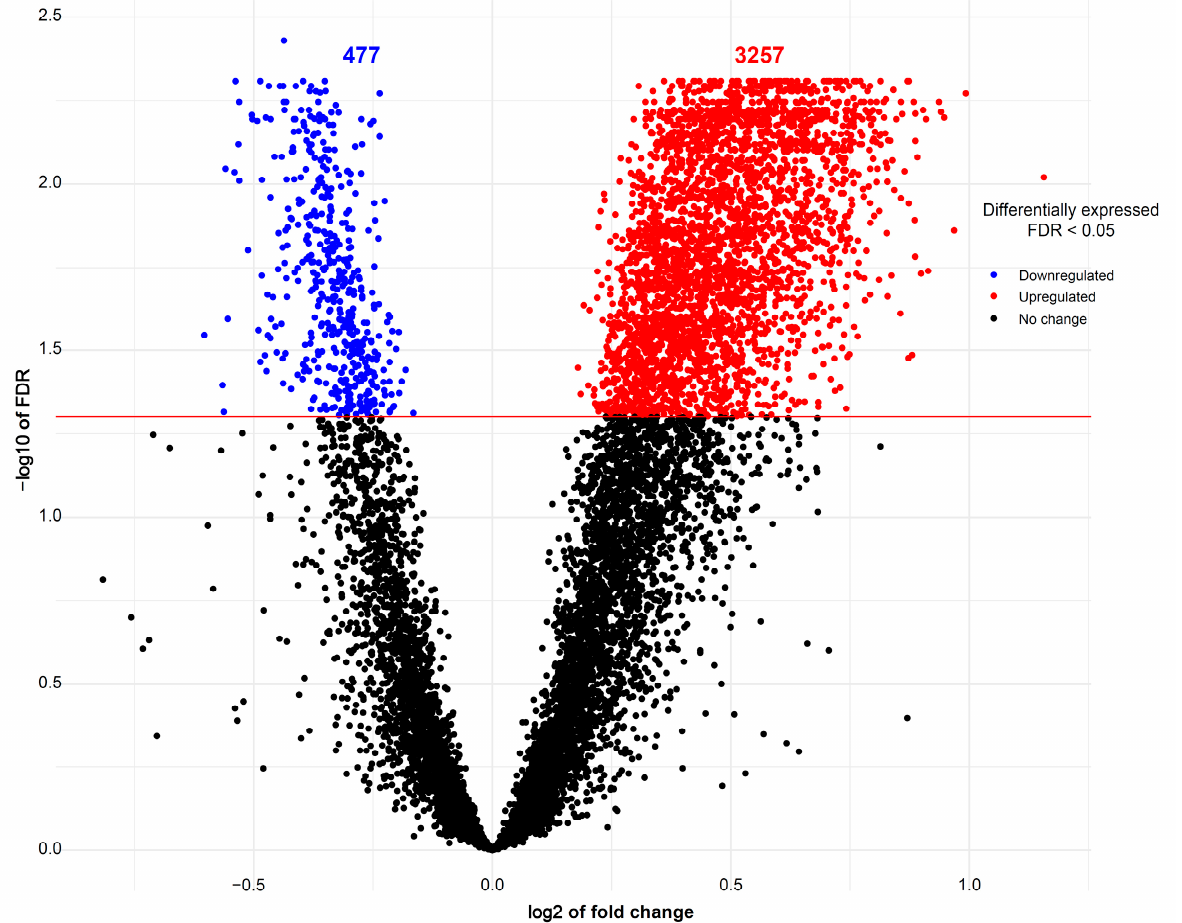
Figure 3. Volcano plots of mRNAs differentially expressed between AGA and IUGR groups. Red spots represent upregulated mRNAs and blue spots indicate downregulated mRNAs in LDM from IUGR fetuses compared to AGA fetuses. Black spots represent mRNAs that did not show changes between AGA and IUGR groups.